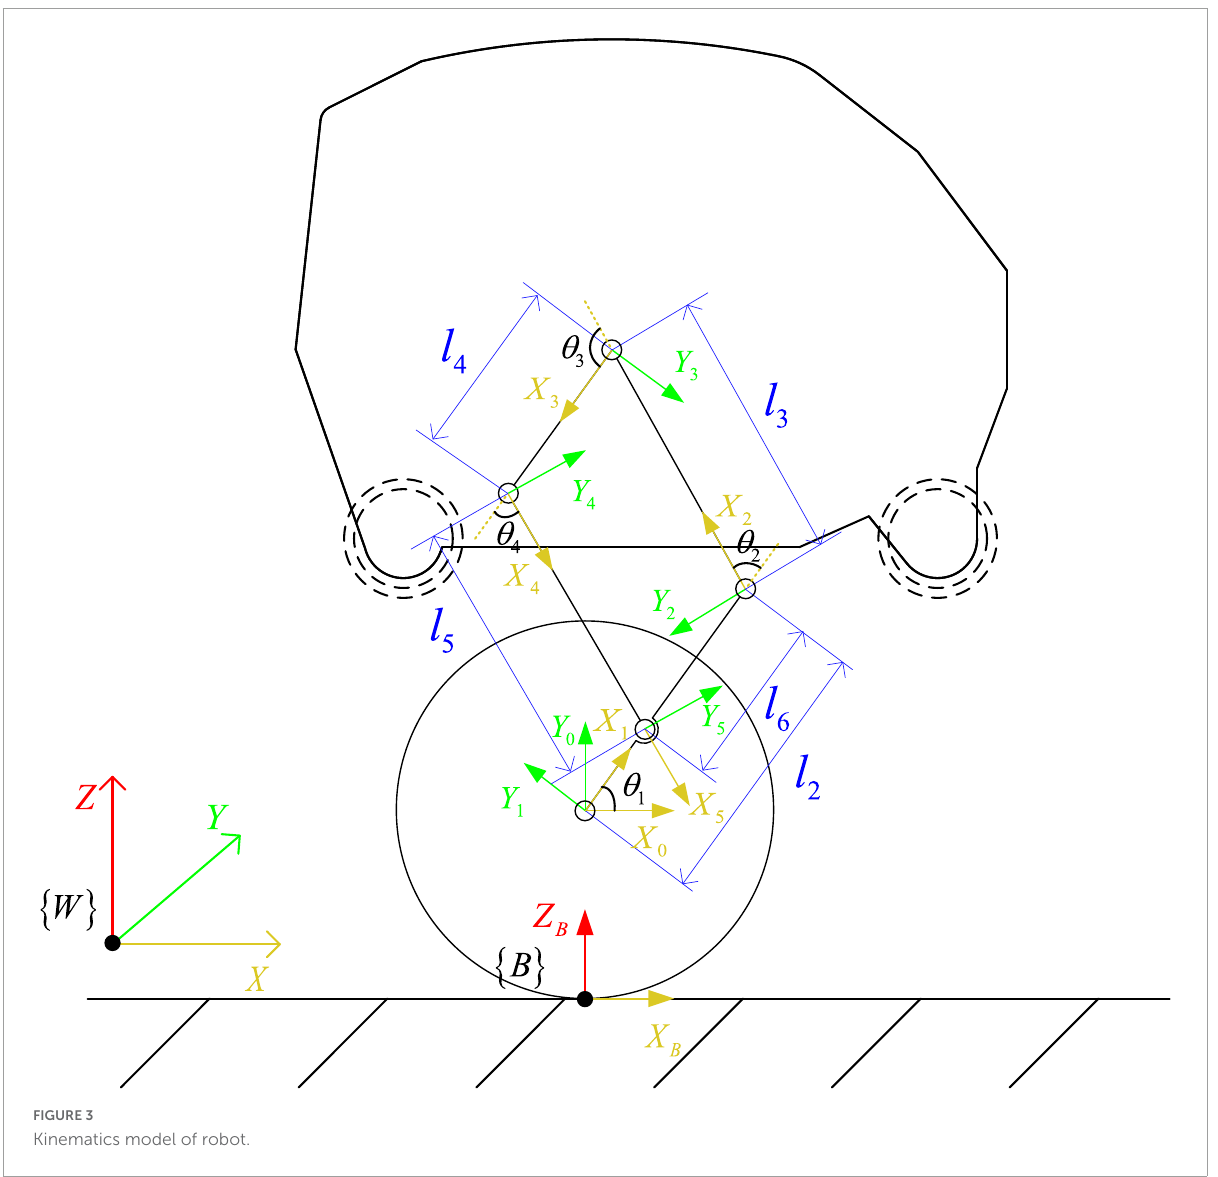
FIGURE3 Kinematics model of robot.